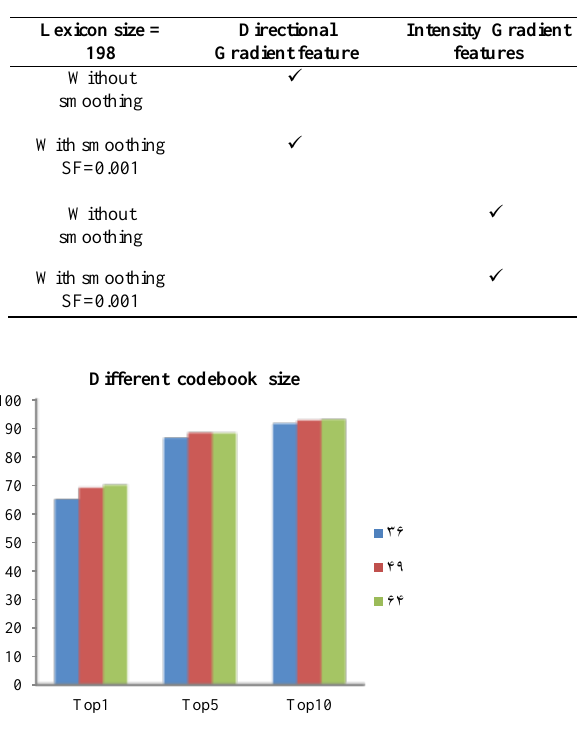
Table1. Comparison of recognition results with two types feature extraction .